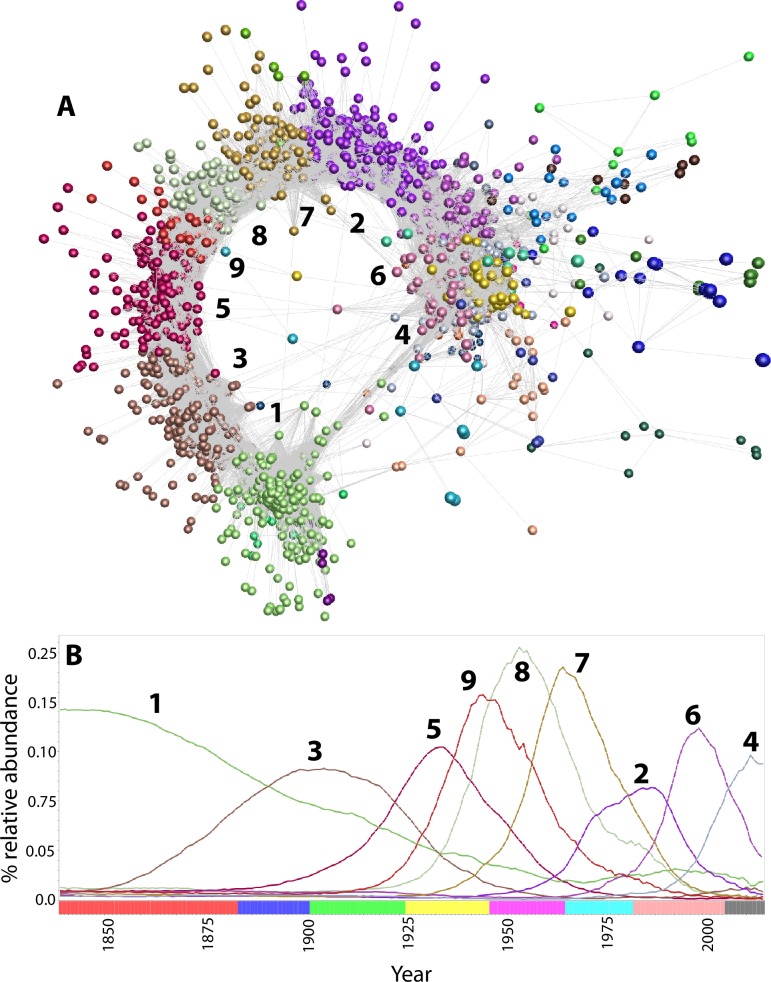
Forename usage in the English and Welsh birth registers (1838–2014).Forename usage represented as (A) a network graph, and (B) as relative abundance over time for nine clusters of names, the contents of which have similar usage profiles. For the network graph, a minimum Pearson correlation coefficient was applied of 0.6, i.e. those edges (correlations) that connect nodes (names) with a value lower than this are excluded. Overall, the graph contains 2835 nodes and 187,480 edges. Each set of coloured nodes represents a cluster of names with similar usage profiles. Selected clusters are numbered both in the network graph and the abundance plot. The contents of each cluster, and those names that do not form a cluster, are available as S12 Table. Name usage data is available as S8 Table. For ease of interpretation, the bar at the base of the abundance plot demarcates generations in arbitrary colours. Using colloquial generation names, from left to right: Georgian/Victorian (year of birth < = 1882), The Lost Generation (1883–1900), The Greatest Generation (1901–1924), The Silent Generation (1925–1945), The Baby Boomers (1946–1964), Generation X (1965–1981), Generation Y/Millenials (1982–2004), Generation Z (> = 2005).